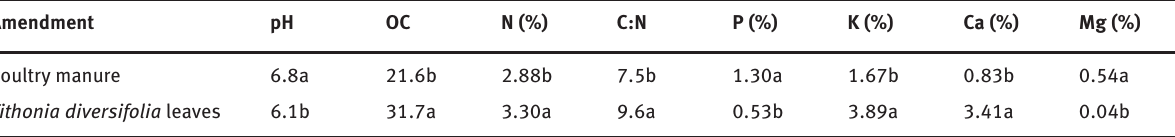
Table 2: Chemical composition of poultry manure and Tithonia diversifolia leaves